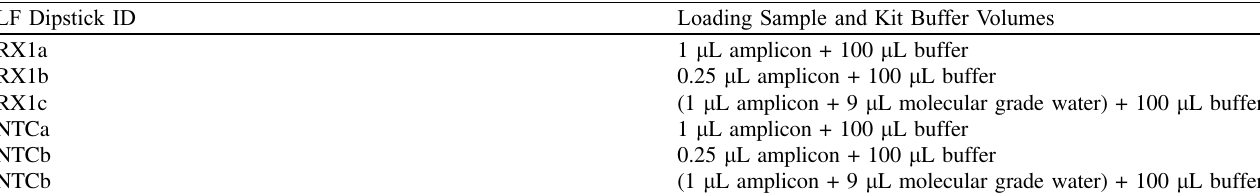
*The same sequences were tagged with FITC and BIO to get tagged FIP and BIP, respectively for the LF-LAMP Assay. Table 3. Optimisation for the tagged LAMP amplicon concentration for the LF assay. LF Dipstick